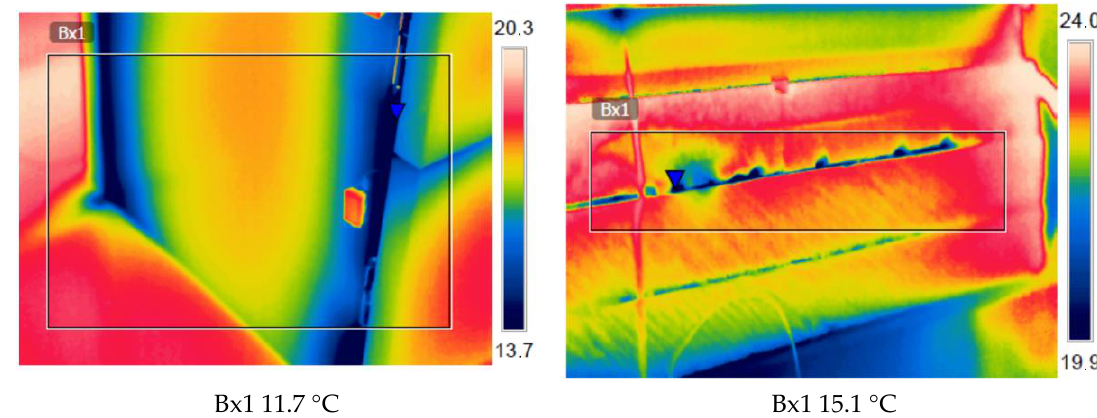
Figure 12. Thermograms of the cooling module—structure leakage: chamber door side wall of the module, caused thermal bridges; insulation leakage between the module and the monoblock .